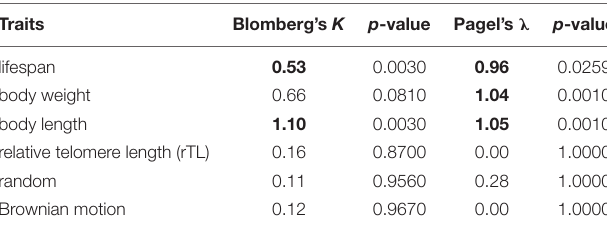
( Table 4 ). The best multivariable model included the log of body weight and the untransformed body length (AIC = 193.04, adjusted R 2 = 0.6479), given a